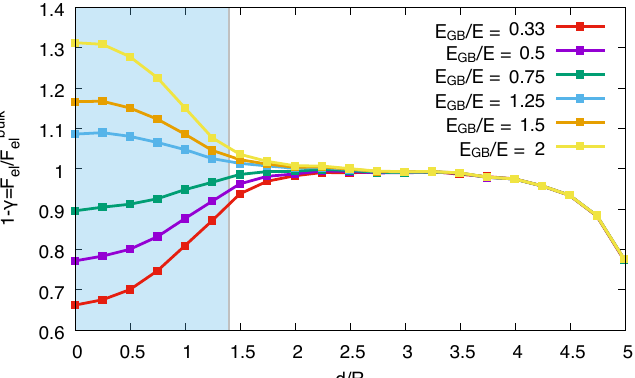
Figure 8. Calculated elastic energy (scaled to the energy of an isolated precipitate in a defect-free and infinite matrix) as a function of the precipitate’s distance to the spatially extended grain boundary, using D GB / R = 0.8. If the precipitate is far away from the grain boundary, the energy reaches a plateau at 1 − γ = 1. If it approaches the top (free) surface of the cylinder (here, for d / R > 3.5; see also Figure 7), the energy drops according to the analysis in Section 2. If the precipitate approaches the grain boundary, the energy change depends on the ratio of Young’s moduli in the grain boundary and bulk, E GB / E . For E GB / E < 1 ( E GB / E > 1), we obtain an energy reduction (increase), corresponding to an attractive (repulsive) interaction between the precipitate and the grain boundary. If the precipitate intersects the grain boundary (blue shaded region), this trend continues.